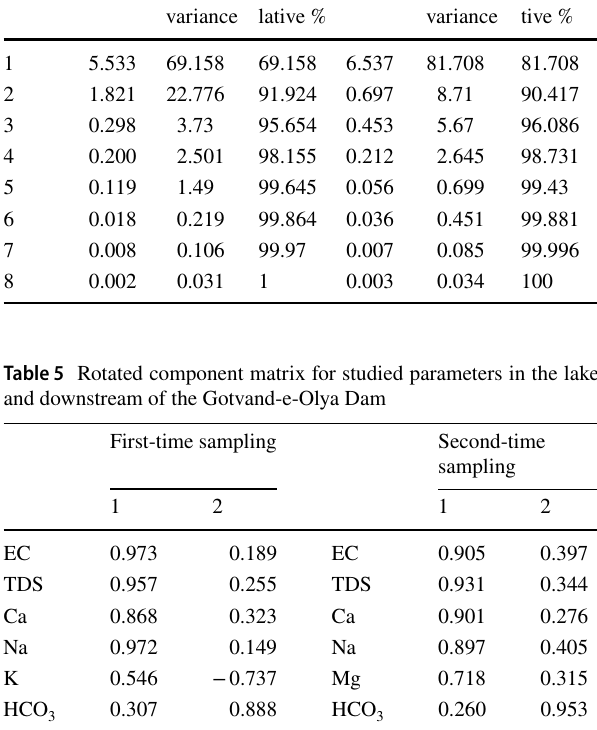
Table 4 Results of factor analysis for studied parameters in the lake and downstream of the Gotvand-e-Olya Dam Compo- nent